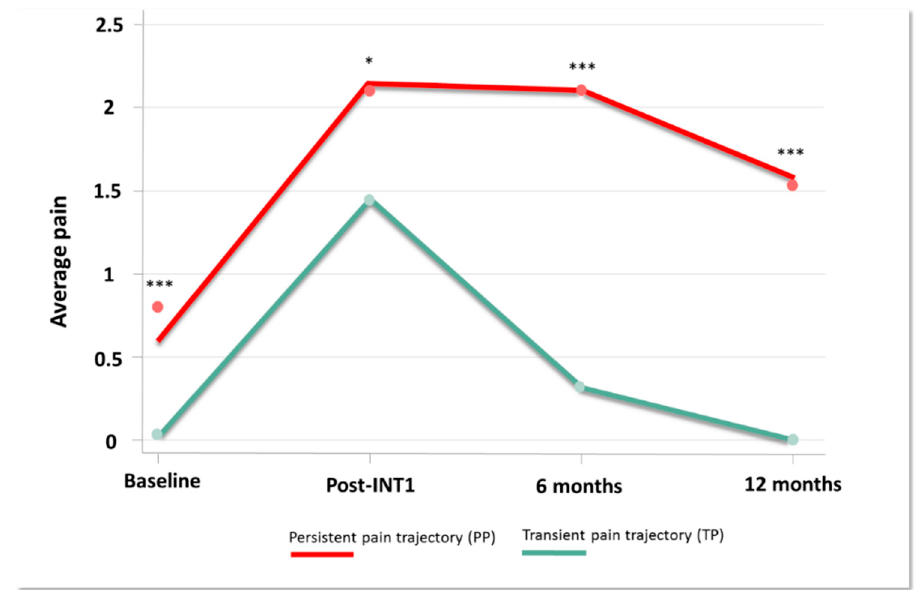
Figure 2. Pain trajectories. Pain intensity (0–10) collected during one year, at the time of cancer diagnosis (Baseline), after the first therapeutic intervention (Post-INT1), 6 months after baseline